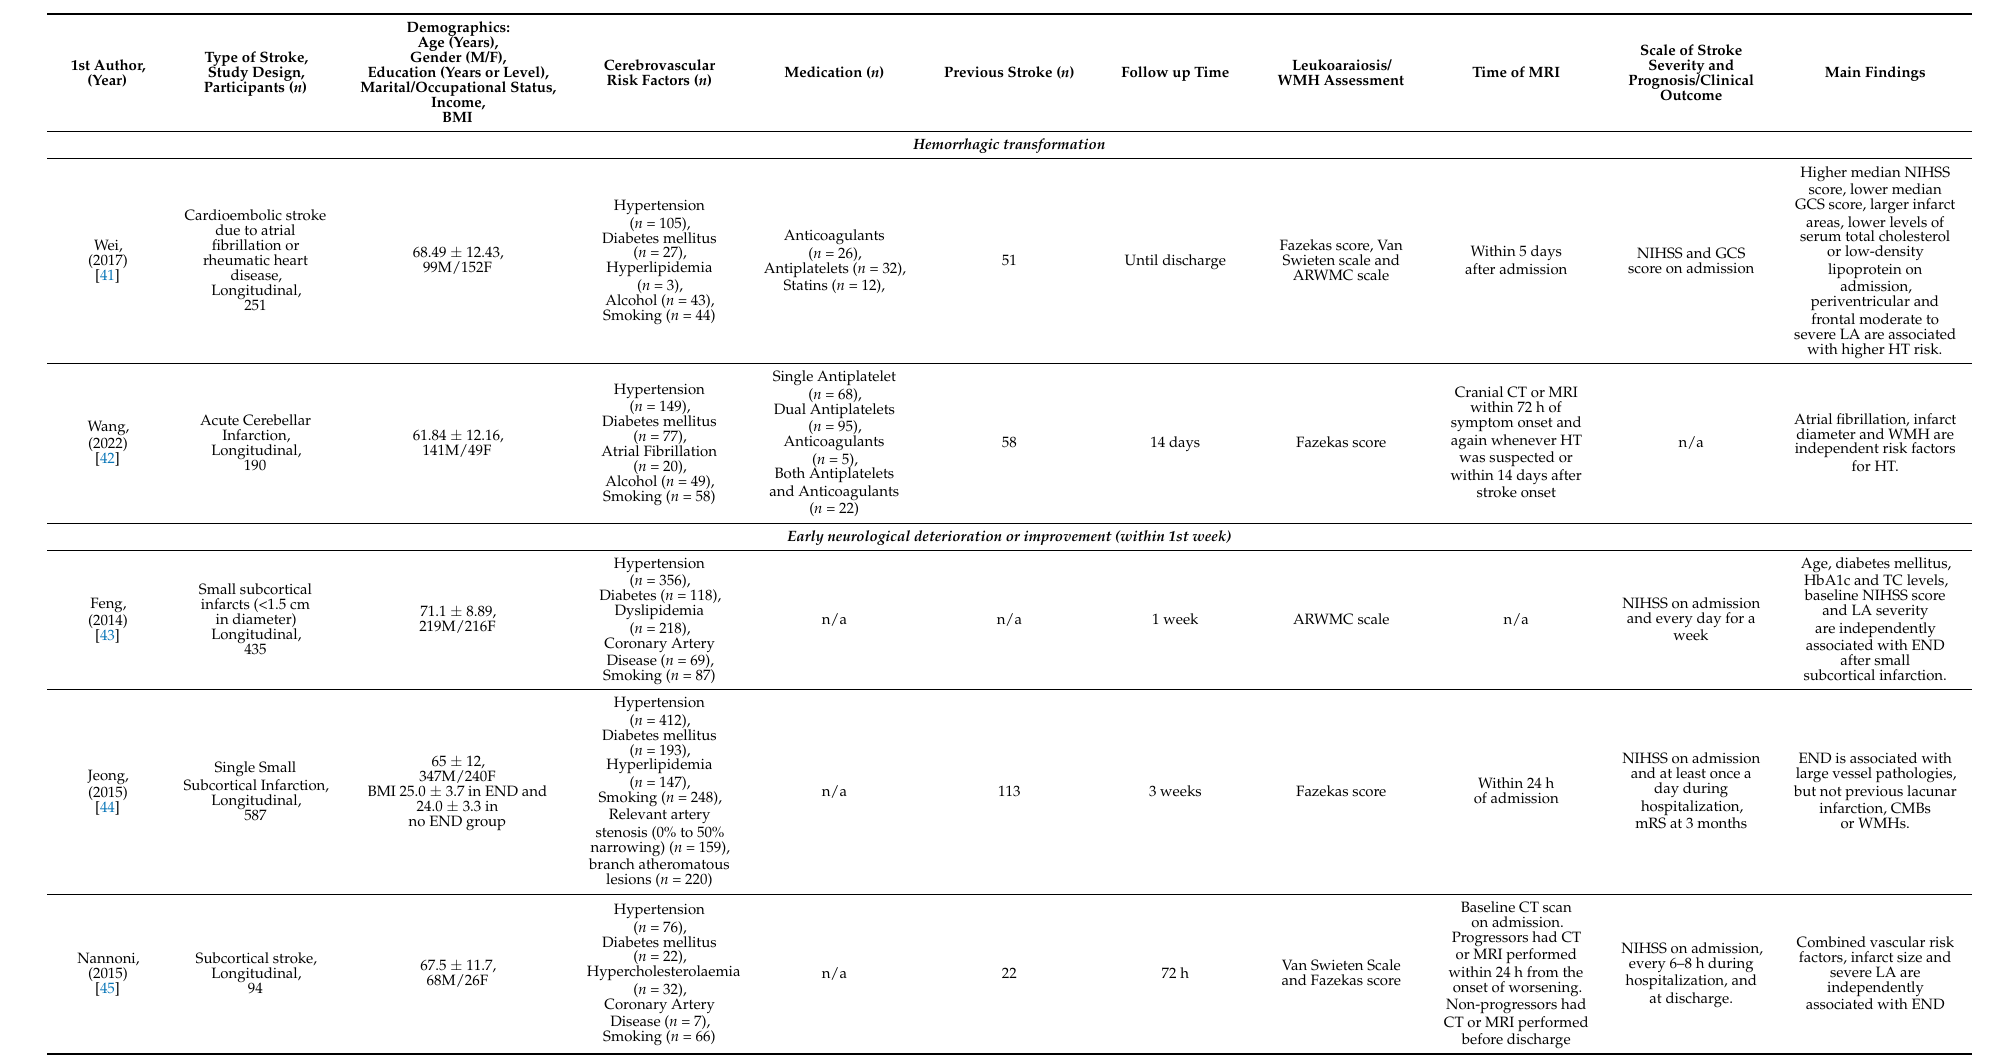
Table 1. Characteristics of the 49 included